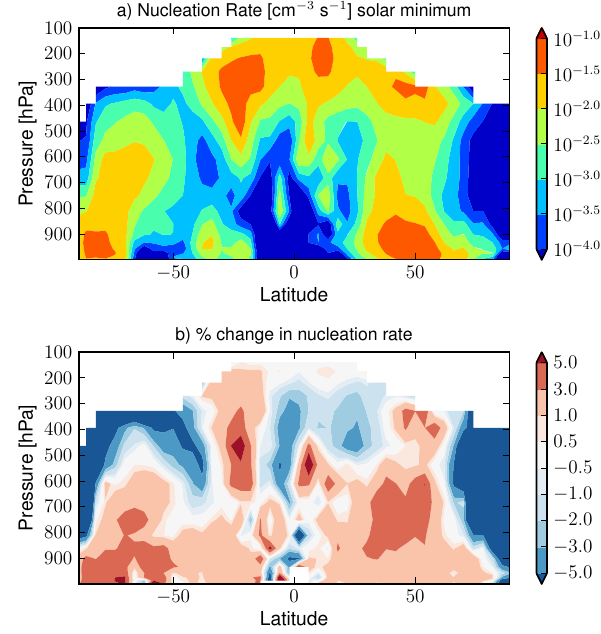
Fig. 5. (a) Zonal-mean nucleation rates in the BASE model simu- lation. (b) Percentage change in nucleation rate between the solar- minimum and solar-maximum BASE simulations. Higher values (red) indicate faster nucleation during the solar minimum (0.4GV modulating potential)